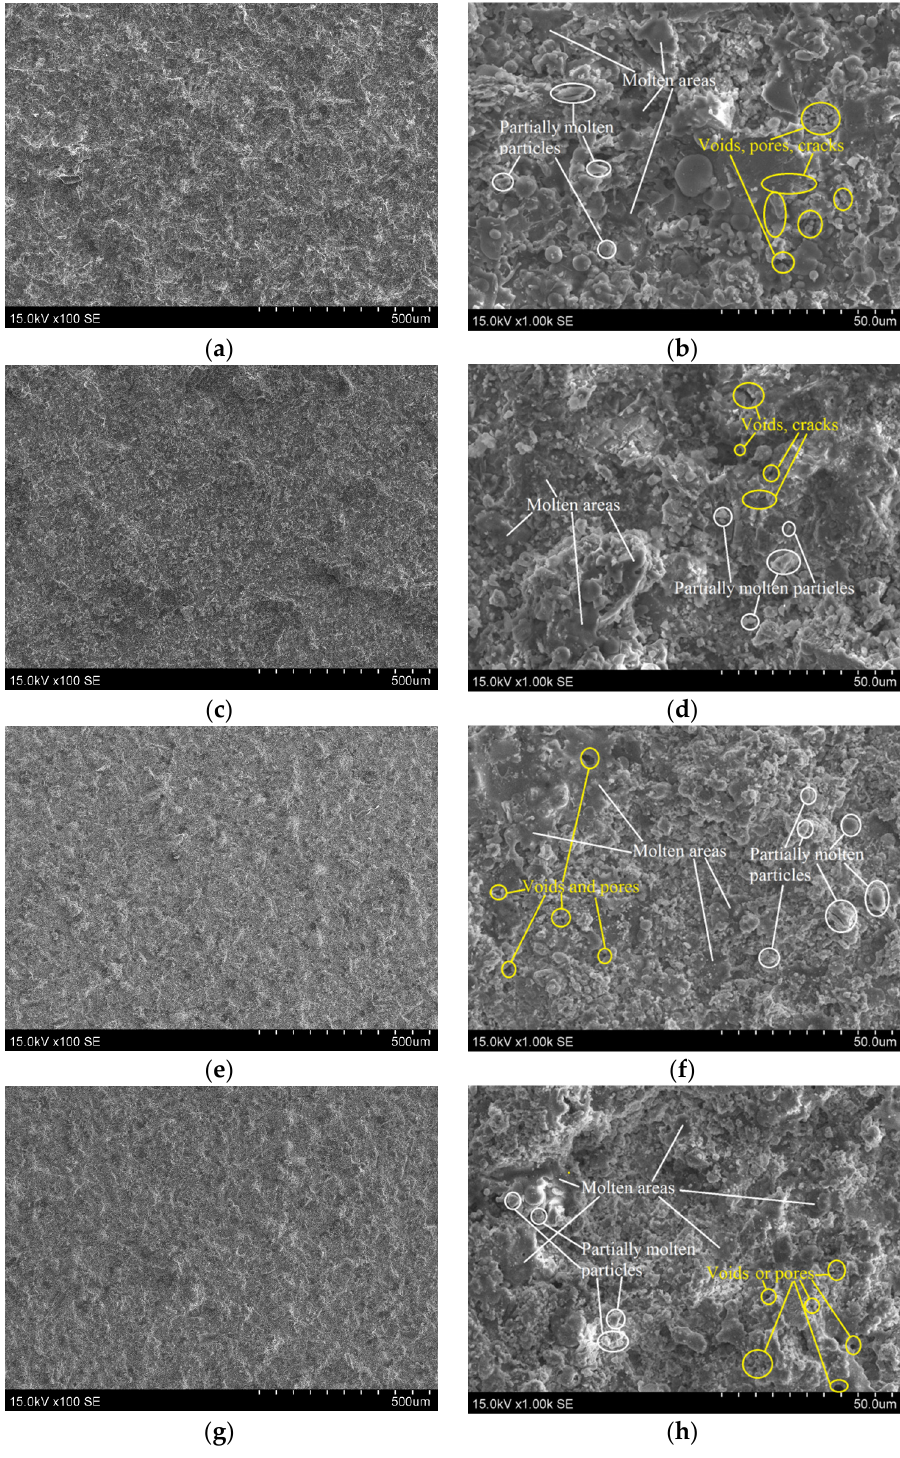
Figure 1. Surface morphology of ( a – d ) Al 2 O 3 and ( e – h ) Al 2 O 3 -ZrO 2 coatings sprayed at ( a , b , e , f ) 180 and ( c , d , g , h ) 220 A.